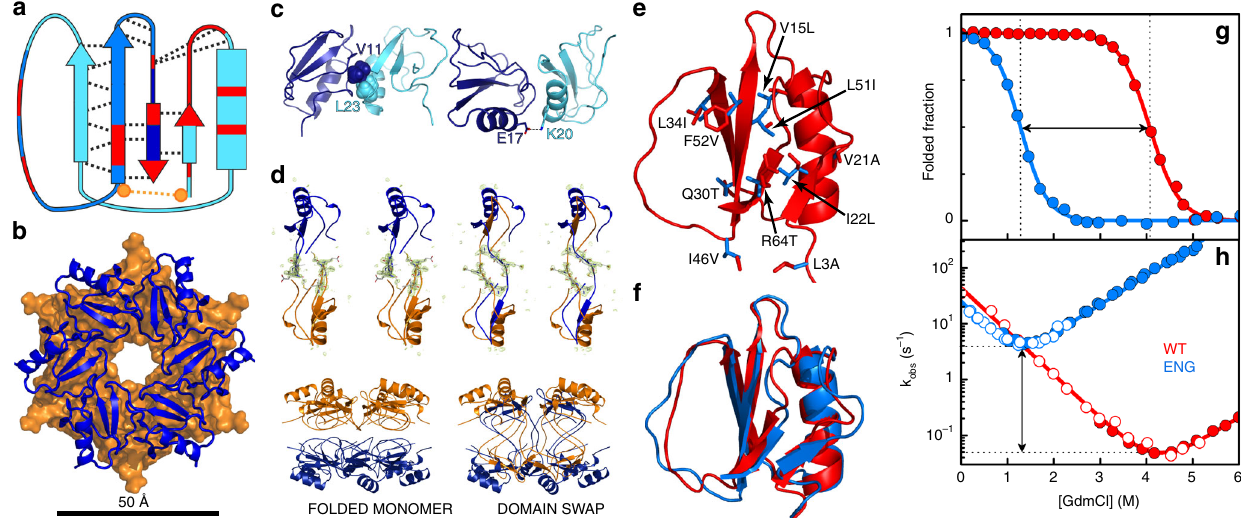
Fig. 2 Engineering CI2 to promote fold switching and assembly. a The native-fold topology of CI2 highlighting the C-terminal antiparallel β -strand (dark blue), highly conserved residues (red), native backbone hydrogen bonds (black dashed lines), the disul fi de bond of trypsin inhibitors (orange), and the domain-swapped segment (medium-shade blue). b Top view of the double hexameric arrangement that CI2 adopts in the crystal lattice (6QIY). c Inter- monomer interactions that stabilize the rings in the crystal. d (Left) side view of the double-ring and stereo view of equivalent monomers from top and bottom rings in the standard structure (6QIY). (Right) as in left for the domain-swapped structure (6QIZ). The omit electron density map contoured at 3.0 σ is shown for the I39 to E43 segment (sticks). e Mutations used to engineer CI2: (red) wild-type side chain and (blue) replaced side chain. f Comparison between the wild-type NMR structure (3CI2.PDB, red) and the structure of monomeric CI2 eng obtained from experimental chemical shifts and CS-Rosetta (blue). g Equilibrium and h kinetics as a function of chemical denaturant for CI2 (red) and CI2 eng (blue). Table 1 Data collection and re fi nement